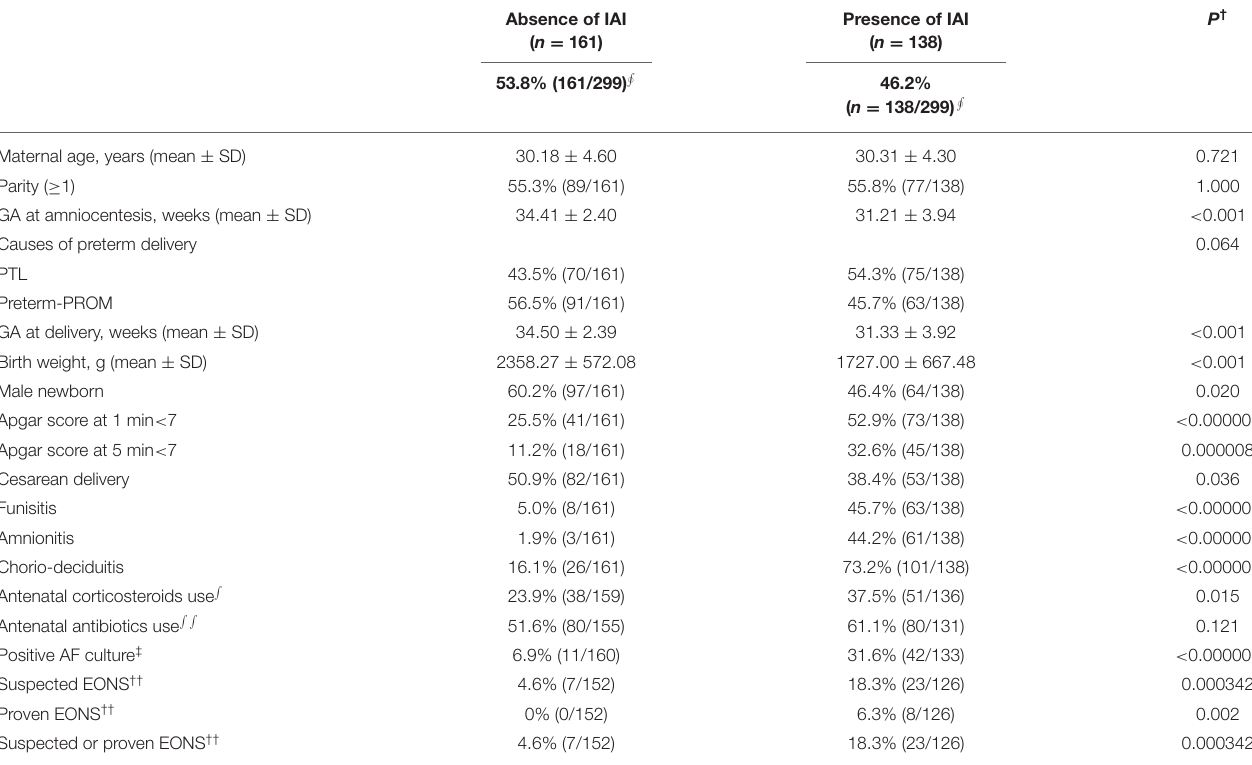
TABLE 2 | Clinical characteristics, and pregnancy and neonatal outcomes according to the presence or absence of intra-amniotic inflammation